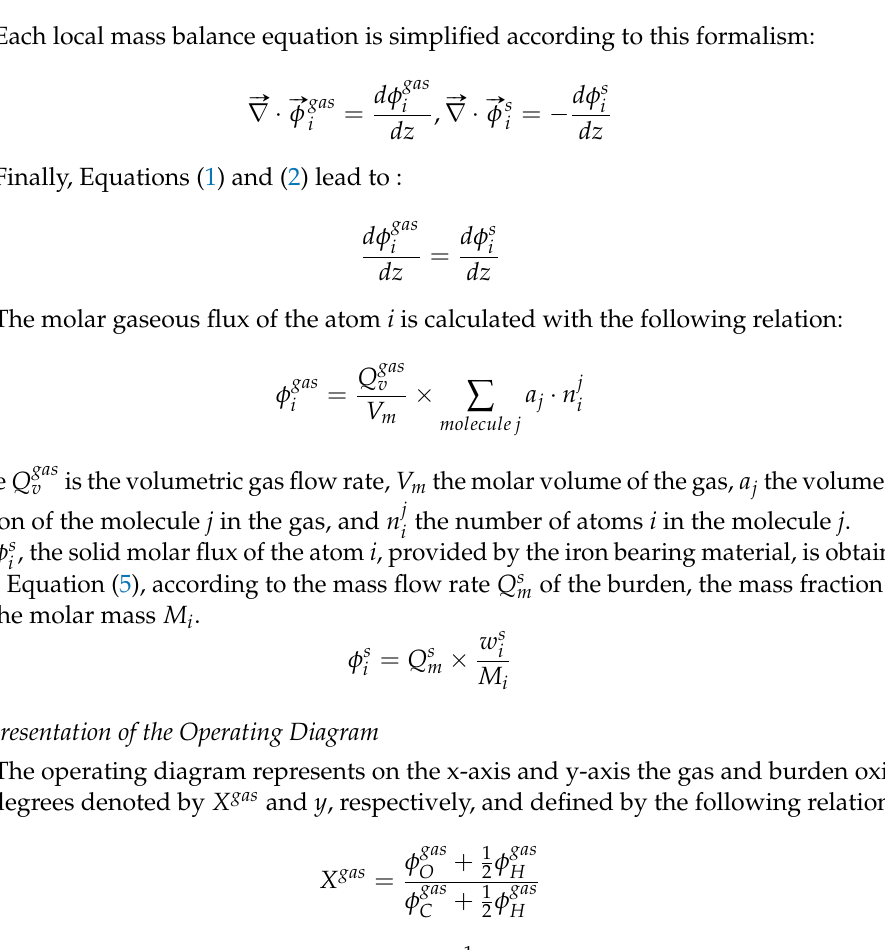
Figure 2. Formalization of the counter-current configuration of the reduction zone in the shaft